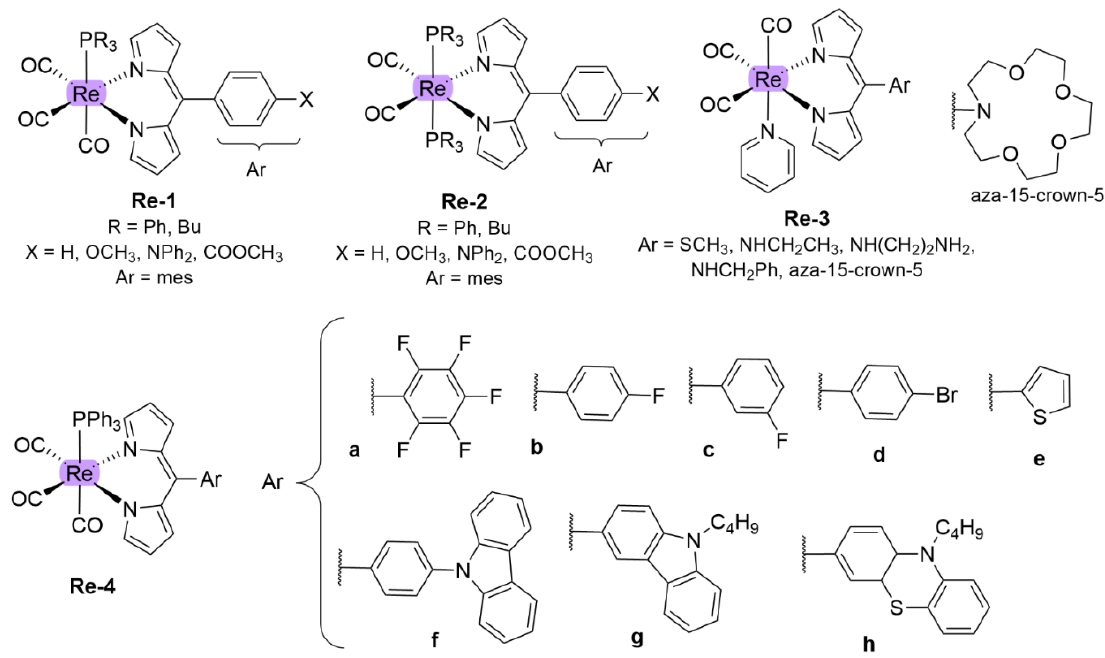
Figure 11. Examples of (dipyrrinato)Re(I) complexes reported in the literature. Telfer and co-workers investigated a range of Re(I) complexes with dipyrrinato lig- ands and different numbers of CO- or phosphine ligands ( Re-1 and Re-2 , Figure 11) [16]. These complexes showed strong absorption in the visible range (470–480 nm, ε up to 4.2 ∗ 10 4 M − 1 cm − 1 ); however, for each complex a weak emission from the π - π * band ( ϕ f = 0–0.006 at ≈ 700 nm) and large Stokes shifts ( ≈ 6000 cm − 1 ) were observed. No exciton coupling